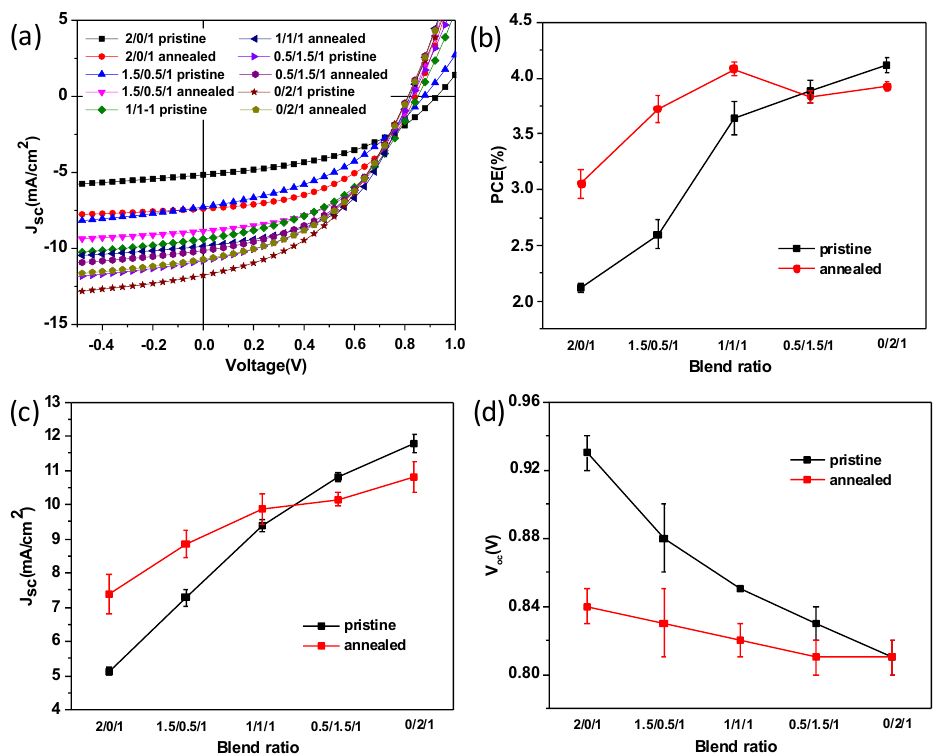
Figure 2. ( a ) J − V curves of devices with and without thermal annealing based on TQ1 / PCE10 / PNDI-T10 blend films with different blend ratios cast from CF and their variation trend of power conversion efficiency (PCE) ( b ), J sc ( c ), and V oc ( d ) with the change of blend ratio, the error bar was obtained based on 4 devices.